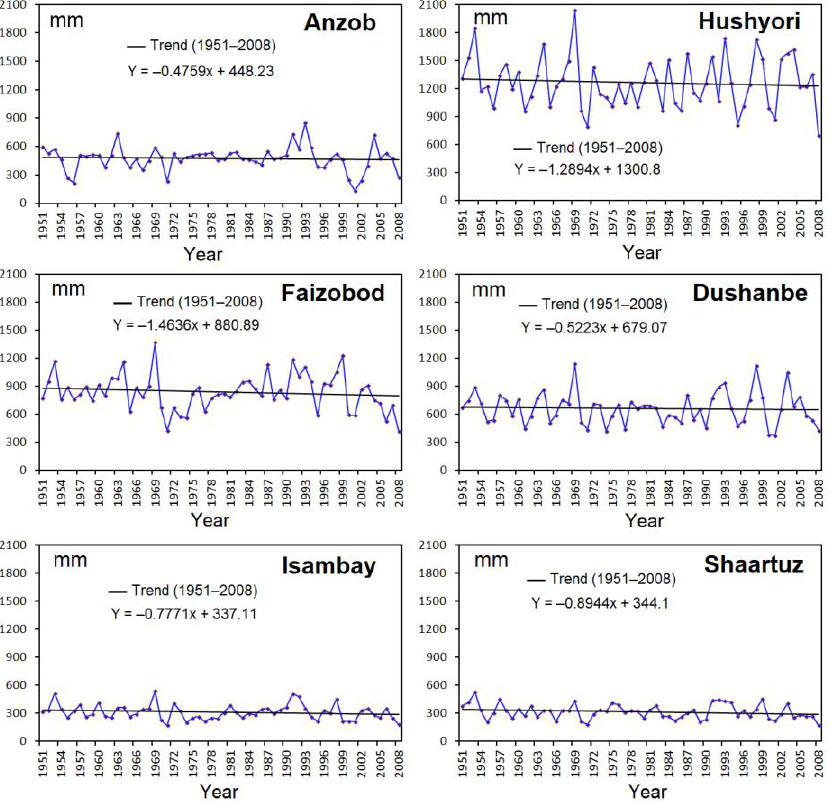
Figure 6. Inter-annual variabilities and trends of annual precipitation during the period of 1951–2008 in the Kofarnihon River Basin, Central Asia.